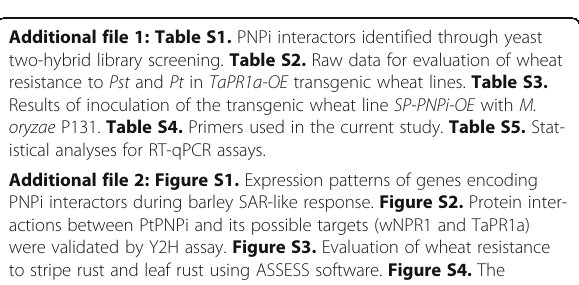
Additional file 1: Table S1. PNPi interactors identified through yeast two-hybrid library screening. Table S2. Raw data for evaluation of wheat resistance to Pst and Pt in TaPR1a-OE transgenic wheat lines. Table S3. Results of inoculation of the transgenic wheat line SP-PNPi-OE with M. oryzae P131. Table S4. Primers used in the current study. Table S5. Stat- istical analyses for RT-qPCR assays. Additional file 2: Figure S1. Expression patterns of genes encoding PNPi interactors during barley SAR-like response. Figure S2. Protein inter- actions between PtPNPi and its possible targets (wNPR1 and TaPR1a) were validated by Y2H assay. Figure S3. Evaluation of wheat resistance to stripe rust and leaf rust using ASSESS software. Figure S4.